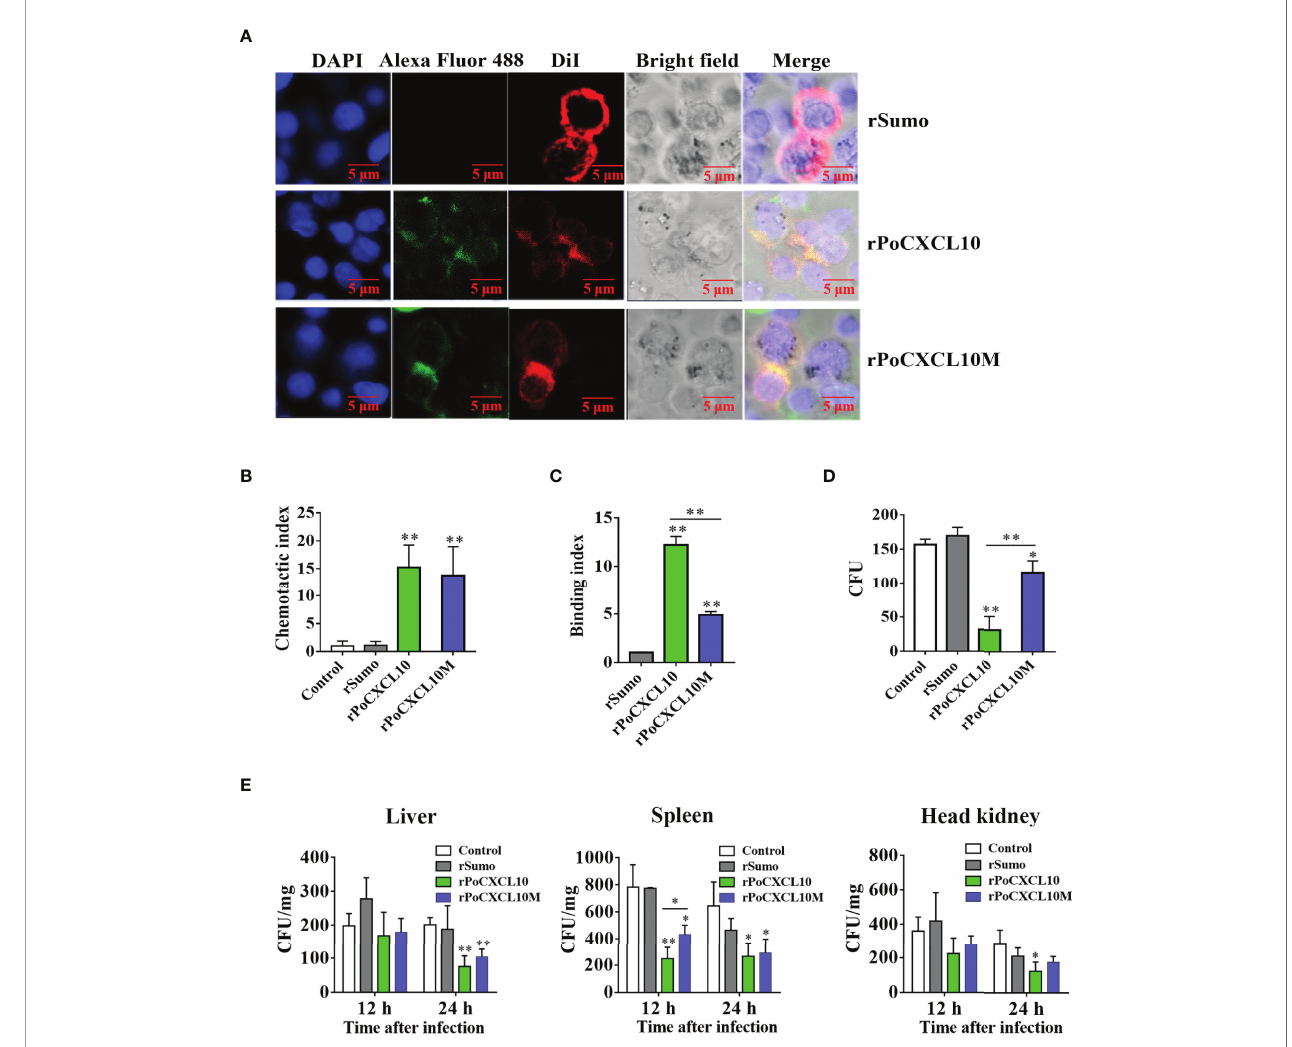
FIGURE 6 | Comparison of the chemotactic and antimicrobial activities of rPoCXCL10 variants. (A) Binding of rPoCXCL10 and rPoCXCL10M to fl ounder peripheral blood leukocytes (PBLs). PBLs were incubated with rPoCXCL10, rPoCXCL10M, or the negative control protein rSumo for 2 h. The cell-bound protein was detected by Alexa Fluor ® 488-conjugated antibody. After staining with DiI and DAPI, the cells were observed with a confocal microscope. Bar size, 2 m m. (B) The chemotactic activities of rPoCXCL10 and rPoCXCL10M against PBLs were determined using Transwell migration assay. Chemotactic index was presented as the ratio of the number of migrated cells induced by rPoCXCL10 or rPoCXCL10M to that induced by PBS (control). (C) Vibrio anguillarum was incubated with rPoCXCL10, rPoCXCL10M, rSumo, or PBS. Bacteria-bound protein was detected by ELISA. (D) V . anguillarum was incubated with rPoCXCL10, rPoCXCL10M, rSumo, or PBS (control) for 4 h. The number of survived bacteria was determined by plate count. (E) Flounder were infected with V. anguillarum in the presence or absence (control) of rPoCXCL10, rPoCXCL10M, or rSumo. At 12 and 24 h post infection, bacterial numbers in the liver, spleen, and head kidney were determined by plate count. For panels (B – E) , values are the means of triplicate experiments and shown as means ± SD. * p < 0.05, ** p <